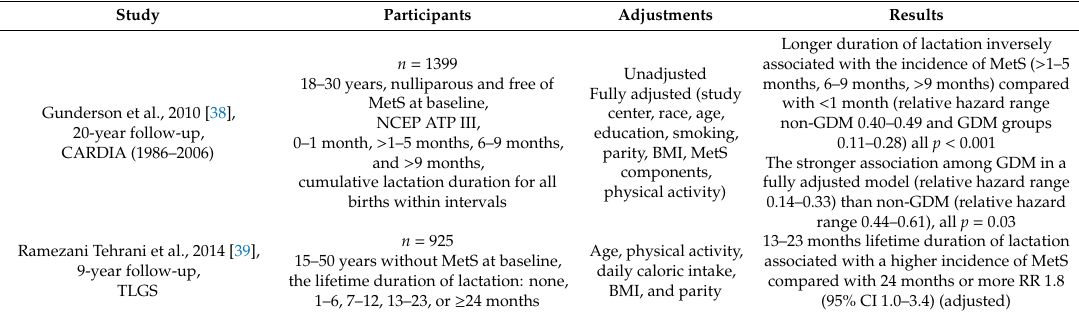
Table 2. Prospective studies on breastfeeding and metabolic syndrome